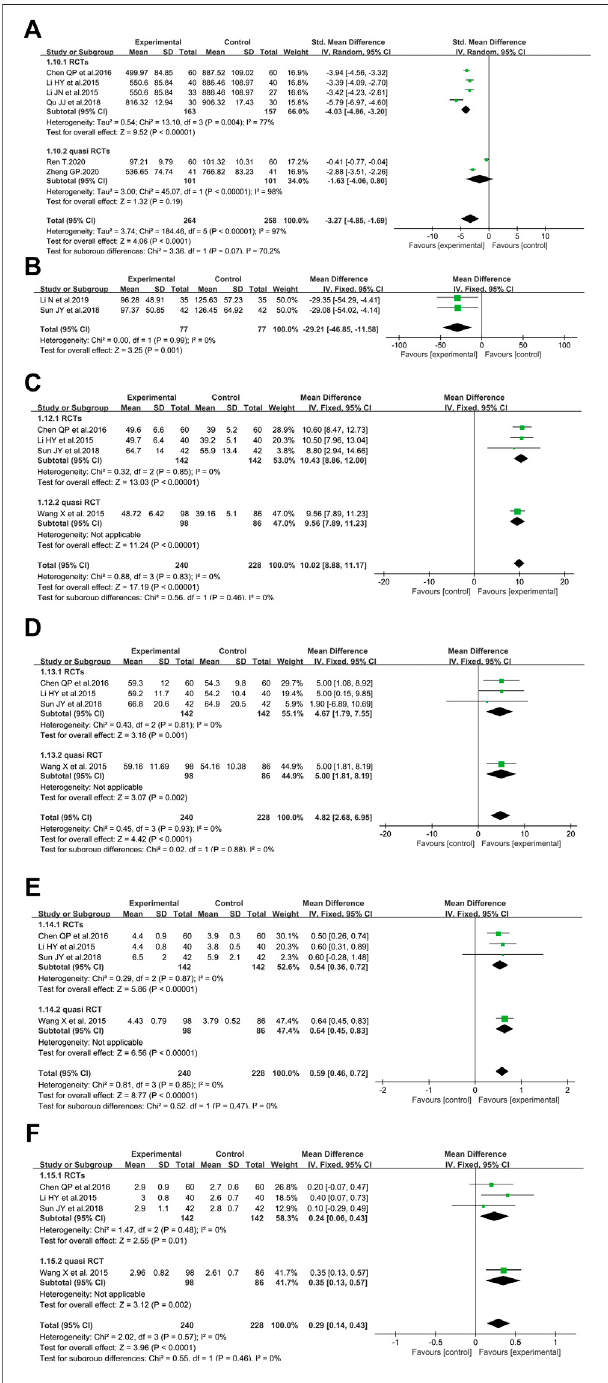
FIGURE 6 | Meta-analysis results of SFI on the cardiovascular system based on: (A) BNP; (B) creatine Kinase; (C) LVEF; (D) stroke volume; (E) cardiac output; (F) cardiac